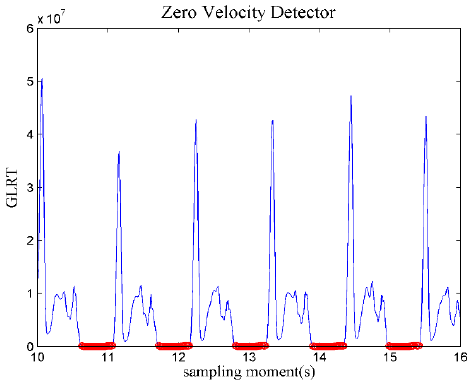
Figure 2. The calculated generalized likelihood ratio (GLRT) at some sampling moments.